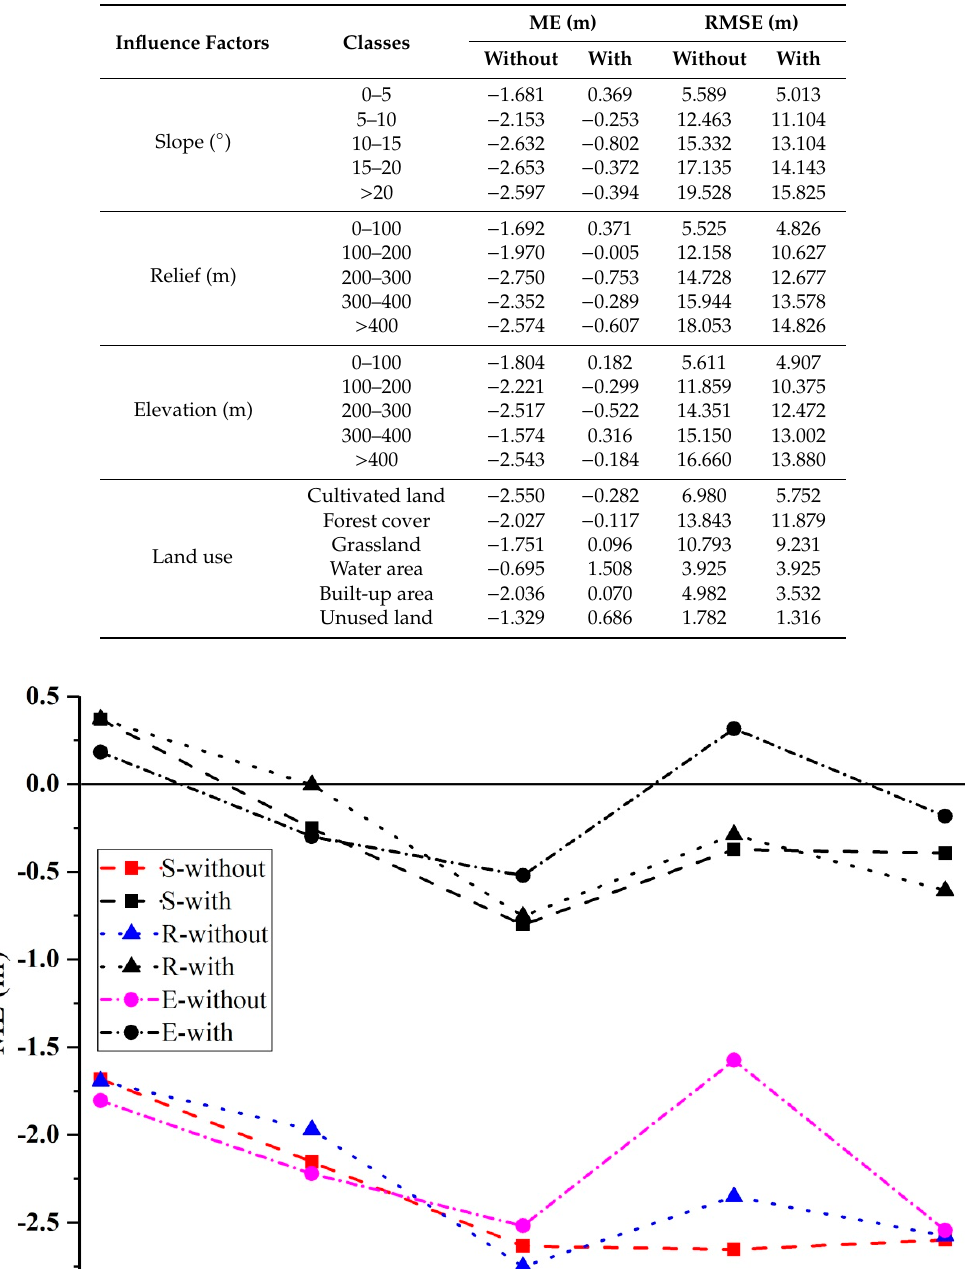
Table 1. Mean errors (MEs) and root mean square errors (RMSEs) of SRTM3 DEM without and with data coregistration under di ff erent classes of the influence factors.